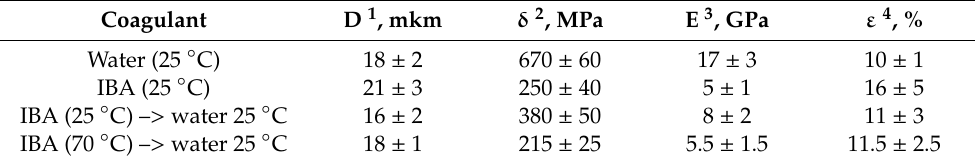
Table 2. Mechanical properties of fibers obtained through various precipitation baths.